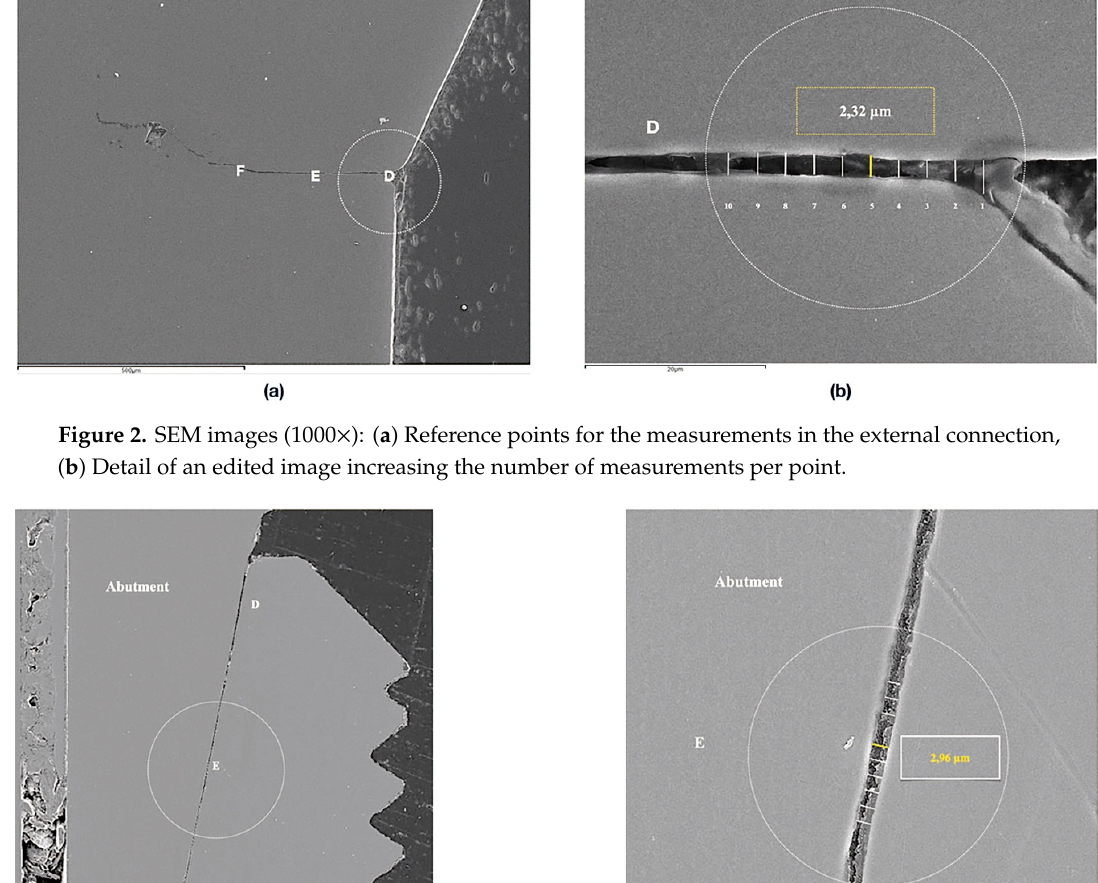
Figure 3. SEM images (1000×): ( a ) Reference points for the measurements in the Morse taper connection. ( b ) Detail of an edited image increasing the number of measurements per point.